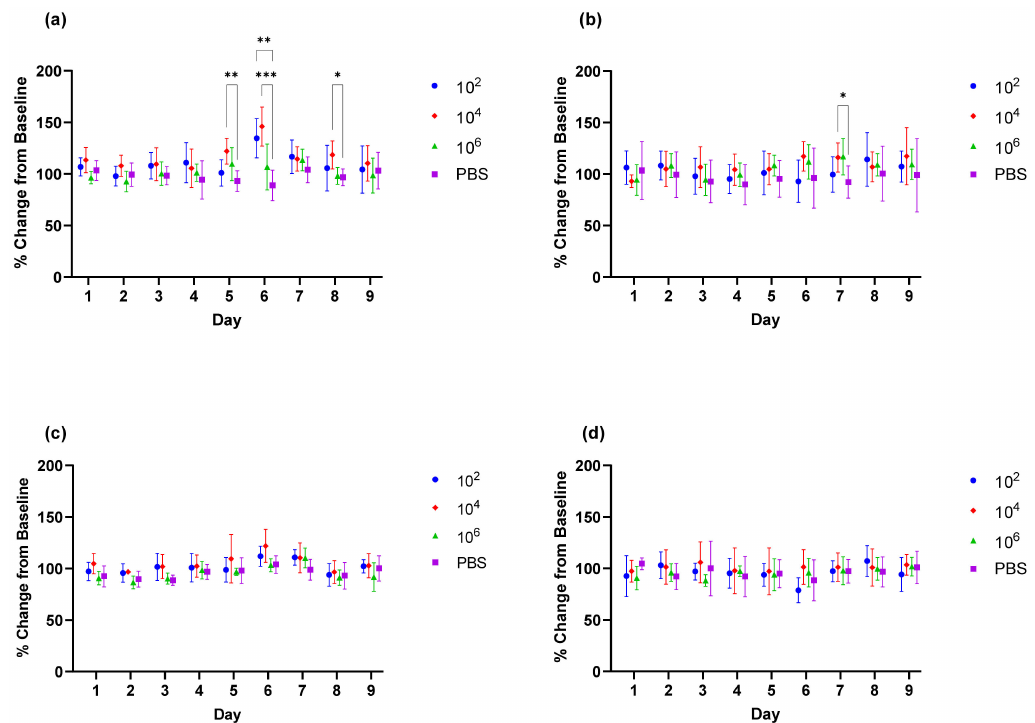
Figure 3. Changes in the left ankle and right ankle of C57BL/6J mice challenged with CHIKV morr/3 (cid:48) del vs. AF15561. Percent change in the left ankle from baseline (day 0) following challenge with CHIKV morr/3 (cid:48) del ( a ) and CHIKV AF15561 ( b ). Percent change in the right ankle from baseline following challenge with CHIKV morr/3 (cid:48) del ( c ) and CHIKV AF15561 ( d ). * p < 0.05, ** p < 0.005, *** p <